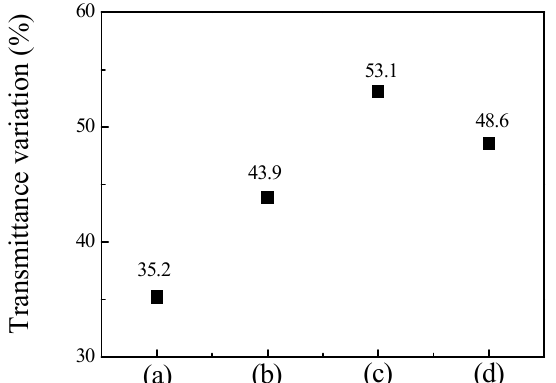
Figure 7. Transmittance variation ( T bleached – T colored ) of ECDs: ( a ) WO 3 ; ( b ) LW1; ( c ) LW2; ( d ) LW3.